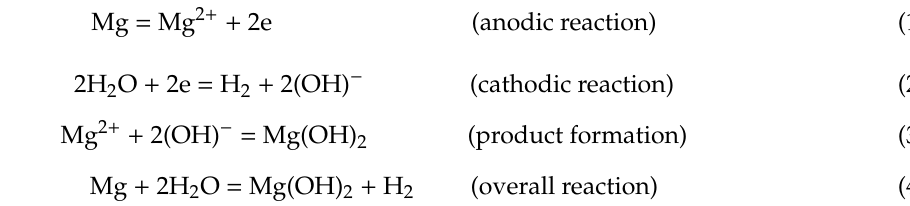
Figure 7. Polarization curves of different samples.